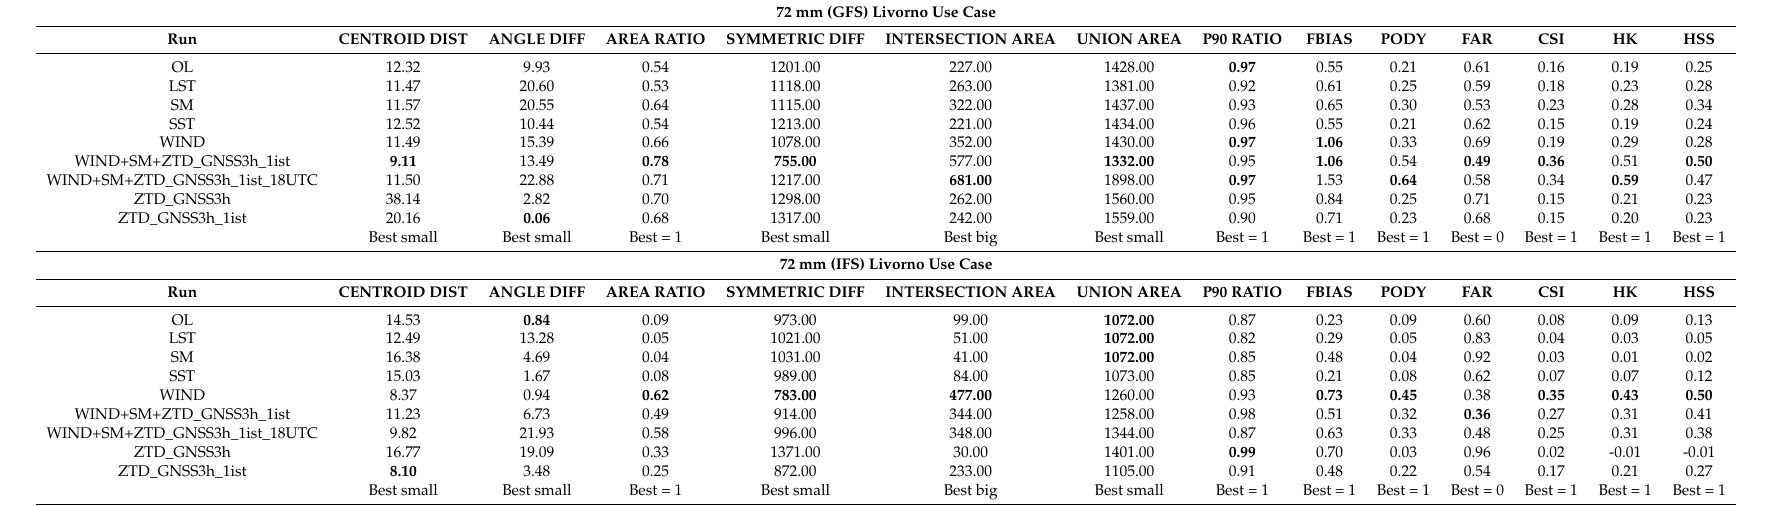
Table A4. Spatial and statistical indices calculated through MODE (72 mm rainfall depth threshold) to evaluate the sensitivity forecasts (driven by GFS and IFS respectively) with respect to the Open Loop run for the time interval 18UTC 09/09/2017–06UTC 10/09/2017. The best performance for each score is highlighted in